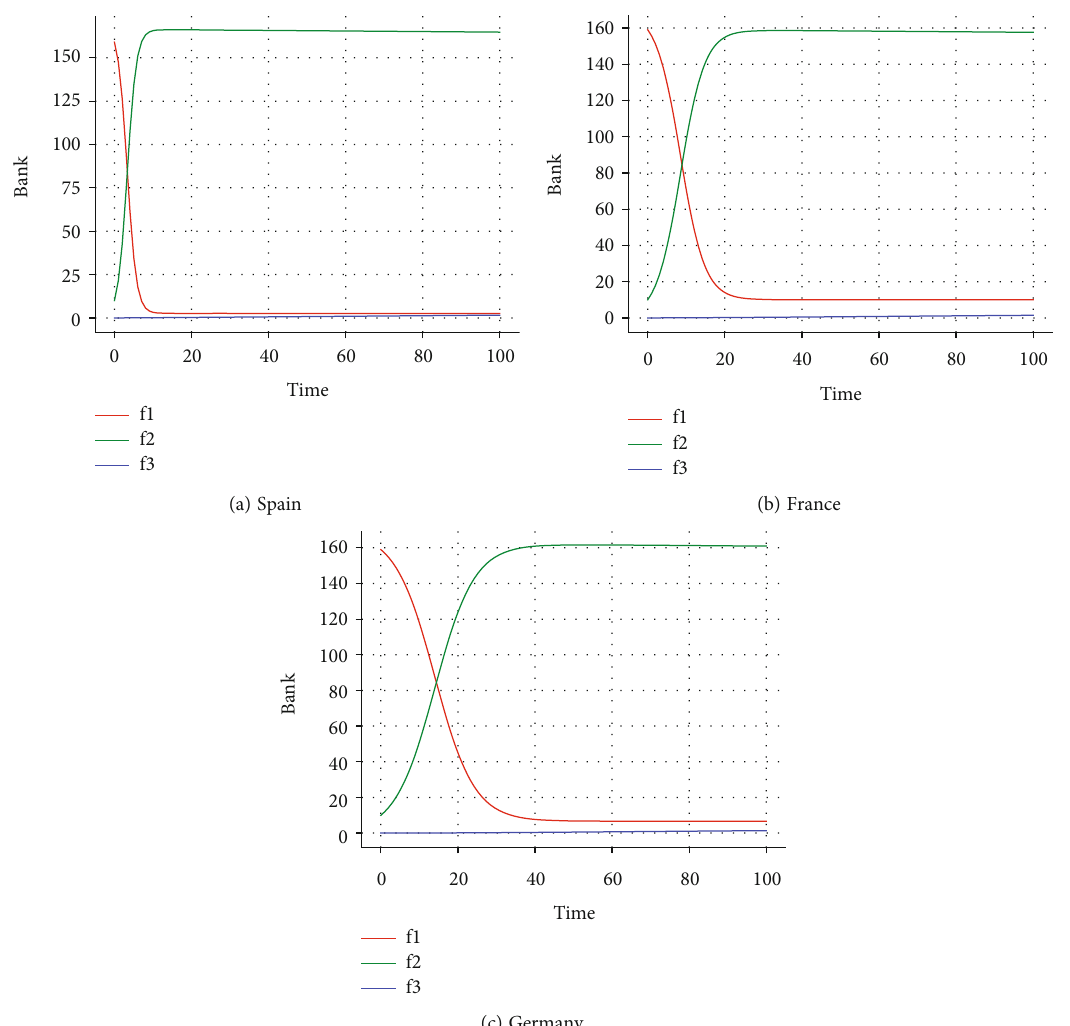
= 0 : 0001 and t = 100 3